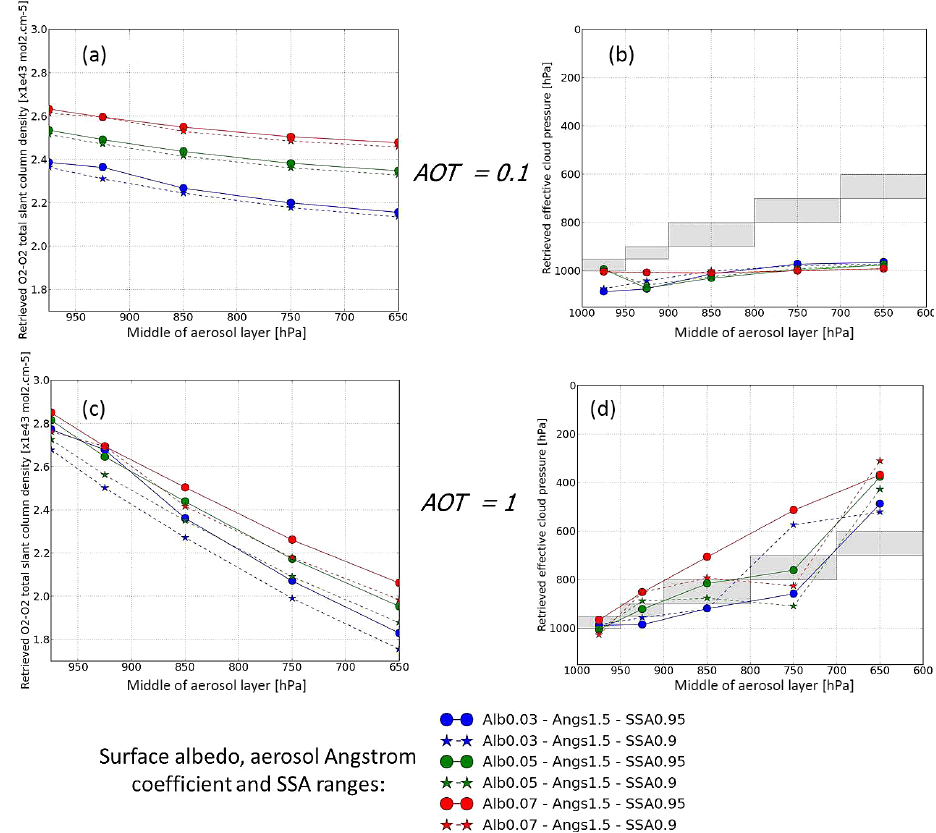
Figure 11. Impact of the location of atmospheric aerosols layers on the simulated DOAS O 2 − O 2 cloud retrieval results as a function of AOT and surface albedo. The results are derived from conditions of Fig. 10a: (a) O 2 − O 2 total SCD for AOT = 0.1, (b) effective cloud pressure (grey colour depicts the location of the simulated aerosol layers) for AOT = 0.1, (c) O 2 − O 2 total SCD for AOT = 1, (d) effective cloud pressure for AOT =